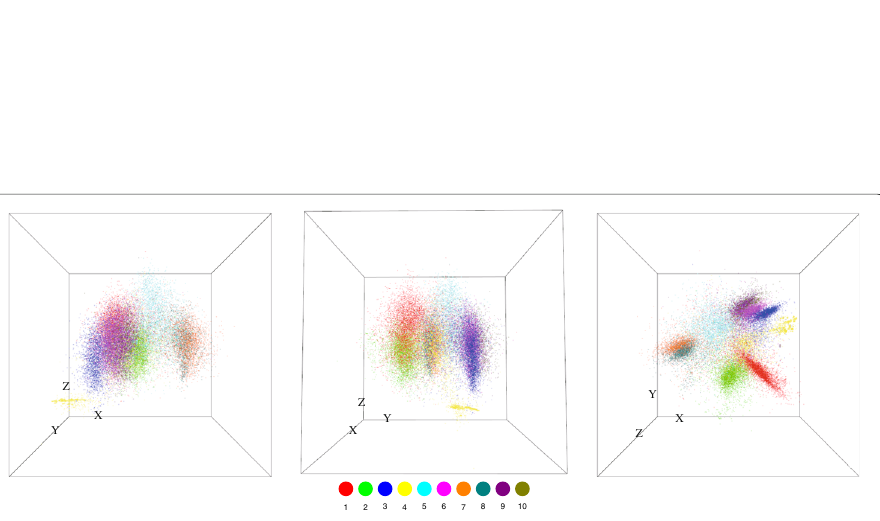
Fig. 12 Histogram of the potential difference (cid:6)φ = φ i − φ j associated with link F ij in the community. A positive value of (cid:6)φ indicates a link directed from the upstream side to the downstream side, while a negative value of (cid:6)φ , a link in the reversed